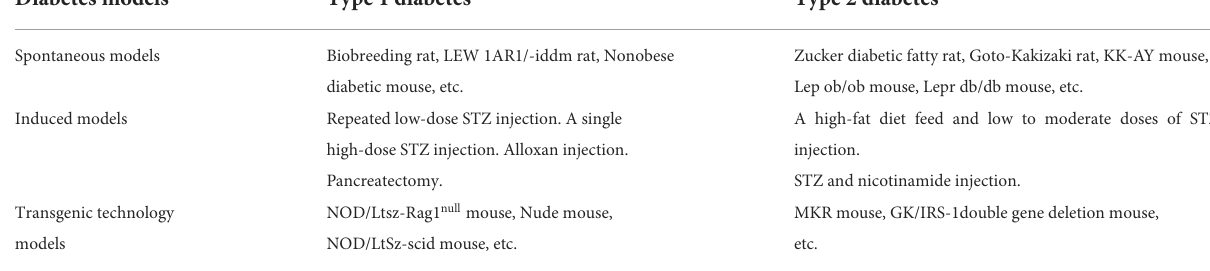
TABLE 3 The methods of common rat and mouse models of DM. Diabetes